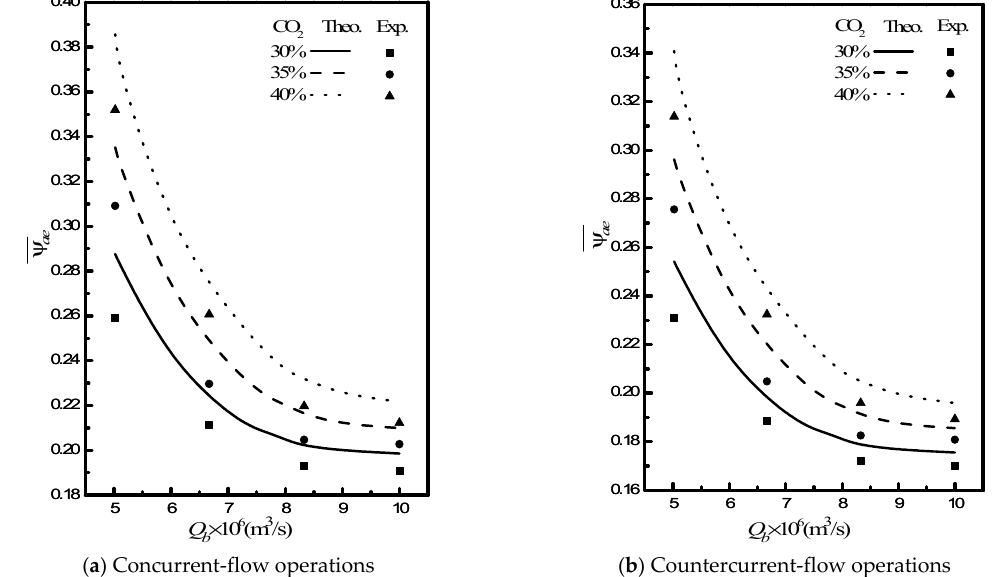
Figure 6. Comparisons of dimensionless outlet CO 2 concentration with various absorbent flow rates. The local mass-transfer Graetz number symbolizes the ratio of mass transfer coefficient in radial direction versus diffusion in axial direction, say Sh ξ = k b ξ D eq , b / D b . The averaged mass-transfer Sherwood number Sh plays a significant role in determining the CO 2 absorption rate in considering the mass transfer behavior. The theoretical prediction Sh which varies with the mass-transfer Graetz number of the absorbent solution (absor- bent flow rates b Q ) for both concurrent- and countercurrent-flow operations is presented in Figure 7, where the averaged mass-transfer Sherwood number Sh in countercurrent- flow operations is higher than that in concurrent-flow operations. This result confirms that the higher mass transfer coefficient is obtained in countercurrent-flow operations that come up with a higher absorption rate due to lower outlet CO 2 concentrations, as demon- strated in Figure 6. It’s reasonable to conclude that the mass transfer rate represented by Sh increases in a linear relationship the smaller the mass-transfer Graetz number of the absorbent solution.